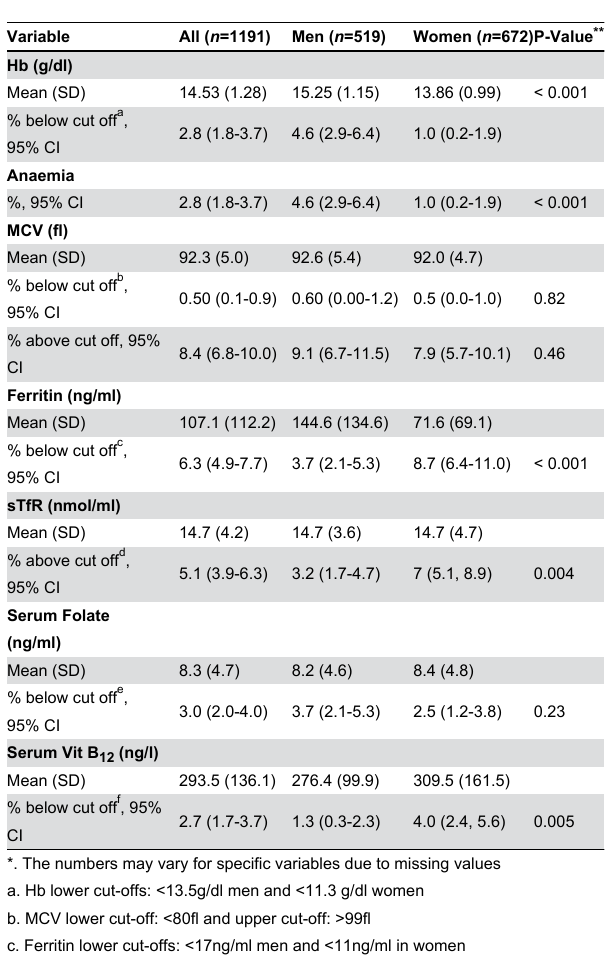
Table 3. Haematinic Deficiency and Relevant Covariates by Gender in Middle-Aged and Older Irish Adults. *